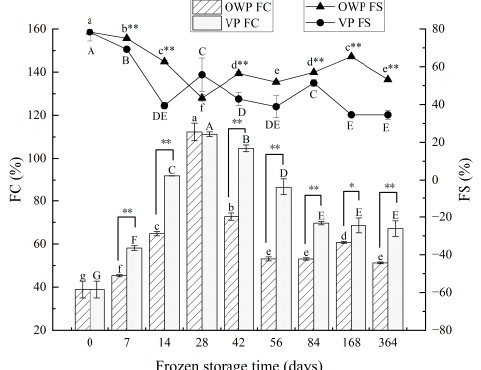
Figure 4. Changes in foaming capacity (FC) and foaming stability (FS) of yak rumen SMP during frozen storage. Different superscript letters in the figure indicate significant difference in storage time ( p < 0.05); lowercase letters are for OWP and uppercase letters for VP. “*” indicates that the different packaging is significant ( p < 0.05), and “**” indicates that the different packaging is extremely significant ( p < 0.01).